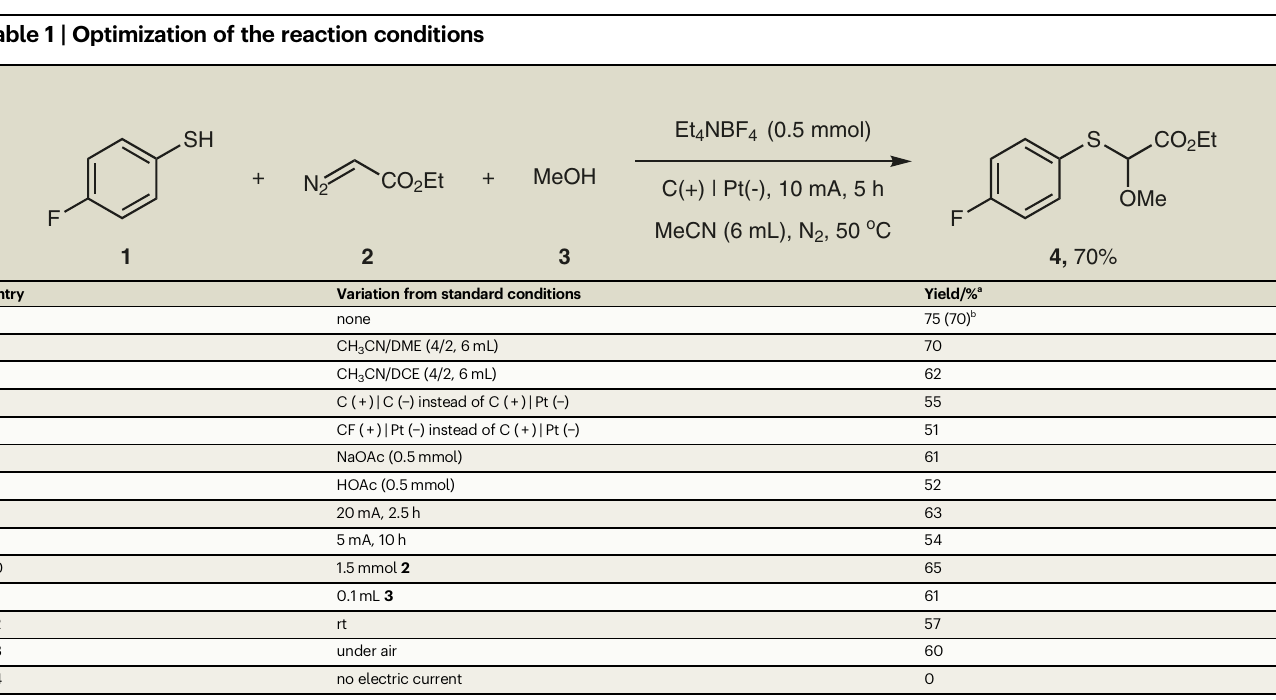
Fig. 1 | Reaction models of diazo compounds. a The carbene reactivity of diazo compounds. b Process via diazonium ion intermediates. c Our design: Electrochemical oxidative difunctionalization of diazo compounds.